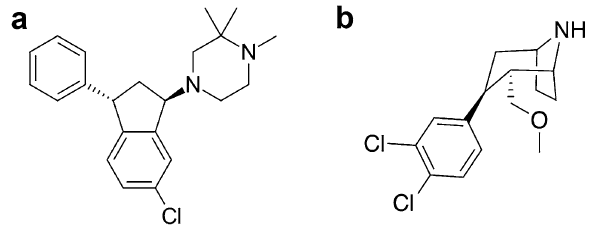
Figure 4. Multi-target compounds. Shown are two exemplary clinical compounds with different activity. Each of these compounds is active against strongly correlated target proteins. ( a ) Zicronapine, with activity against